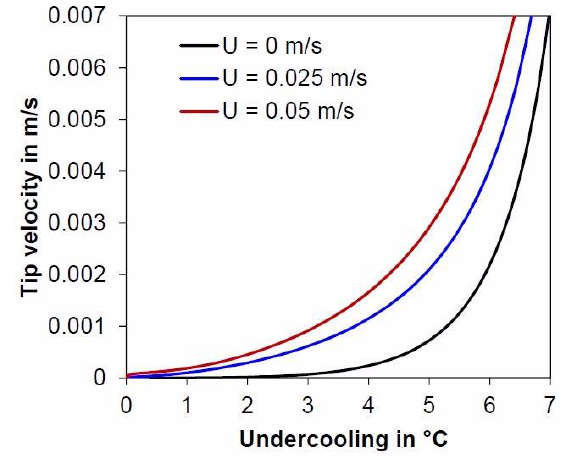
Figure 4. Undercooling as a function of the tip velocity for several fluid flow intensity convections.